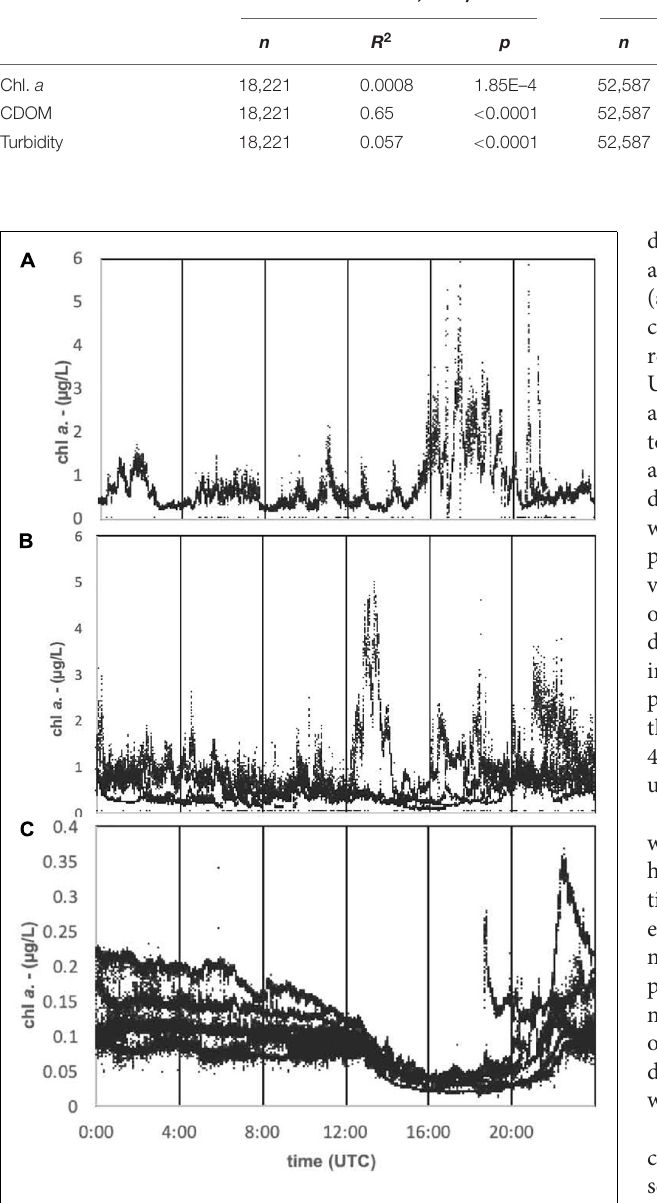
FIGURE 8 | To examine diel trends, daily time series for chl. a are presented for the (A) December 18–19, 2017, (B) December 20–23, 2017, and (C) January 31–February 6, 2018 deployments. Multiple days are depicted on the same plots. Note that the y -axis magnitudes are different for the January 31–February 6, 2018